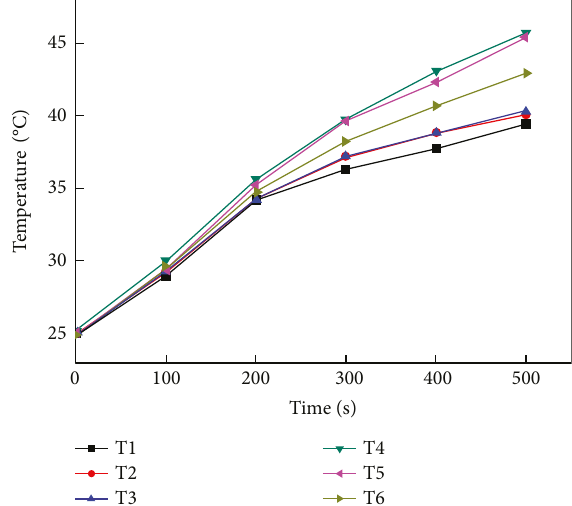
Figure 9: Temperature test results of pulse discharge experiments.